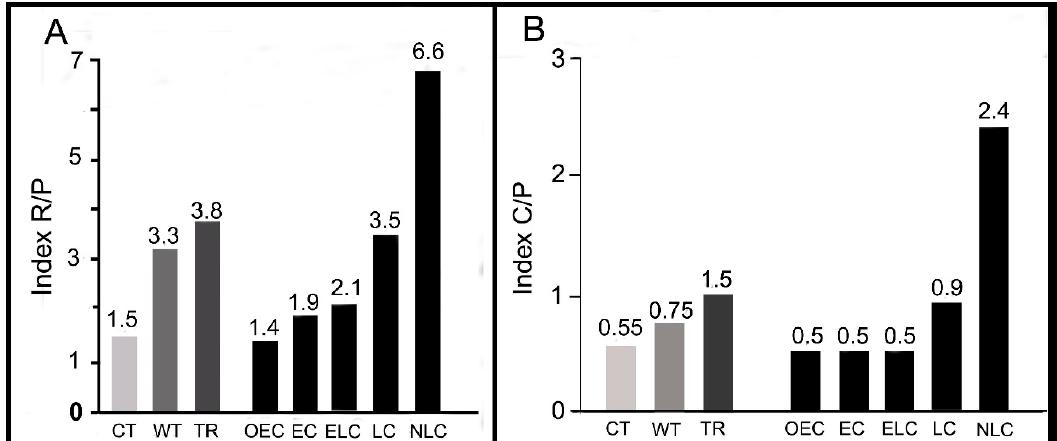
Figure 7. The average levels of the R / P indices (number of Rhodophyta species divided by the number of Phaeophycean species) ( A ) and C / P (number of Chlorophyta species divided by the number of Phaeophycean species) ( B ) in the marine floras of cold-temperate region (CT), warm-temperate region (WT), tropical region (TR) [20], in the early collection (EC) and late collection (LC), and also in the following groups of new findings in LC (NLC), common species in EC and LC (ELC) and species recorded only in EC